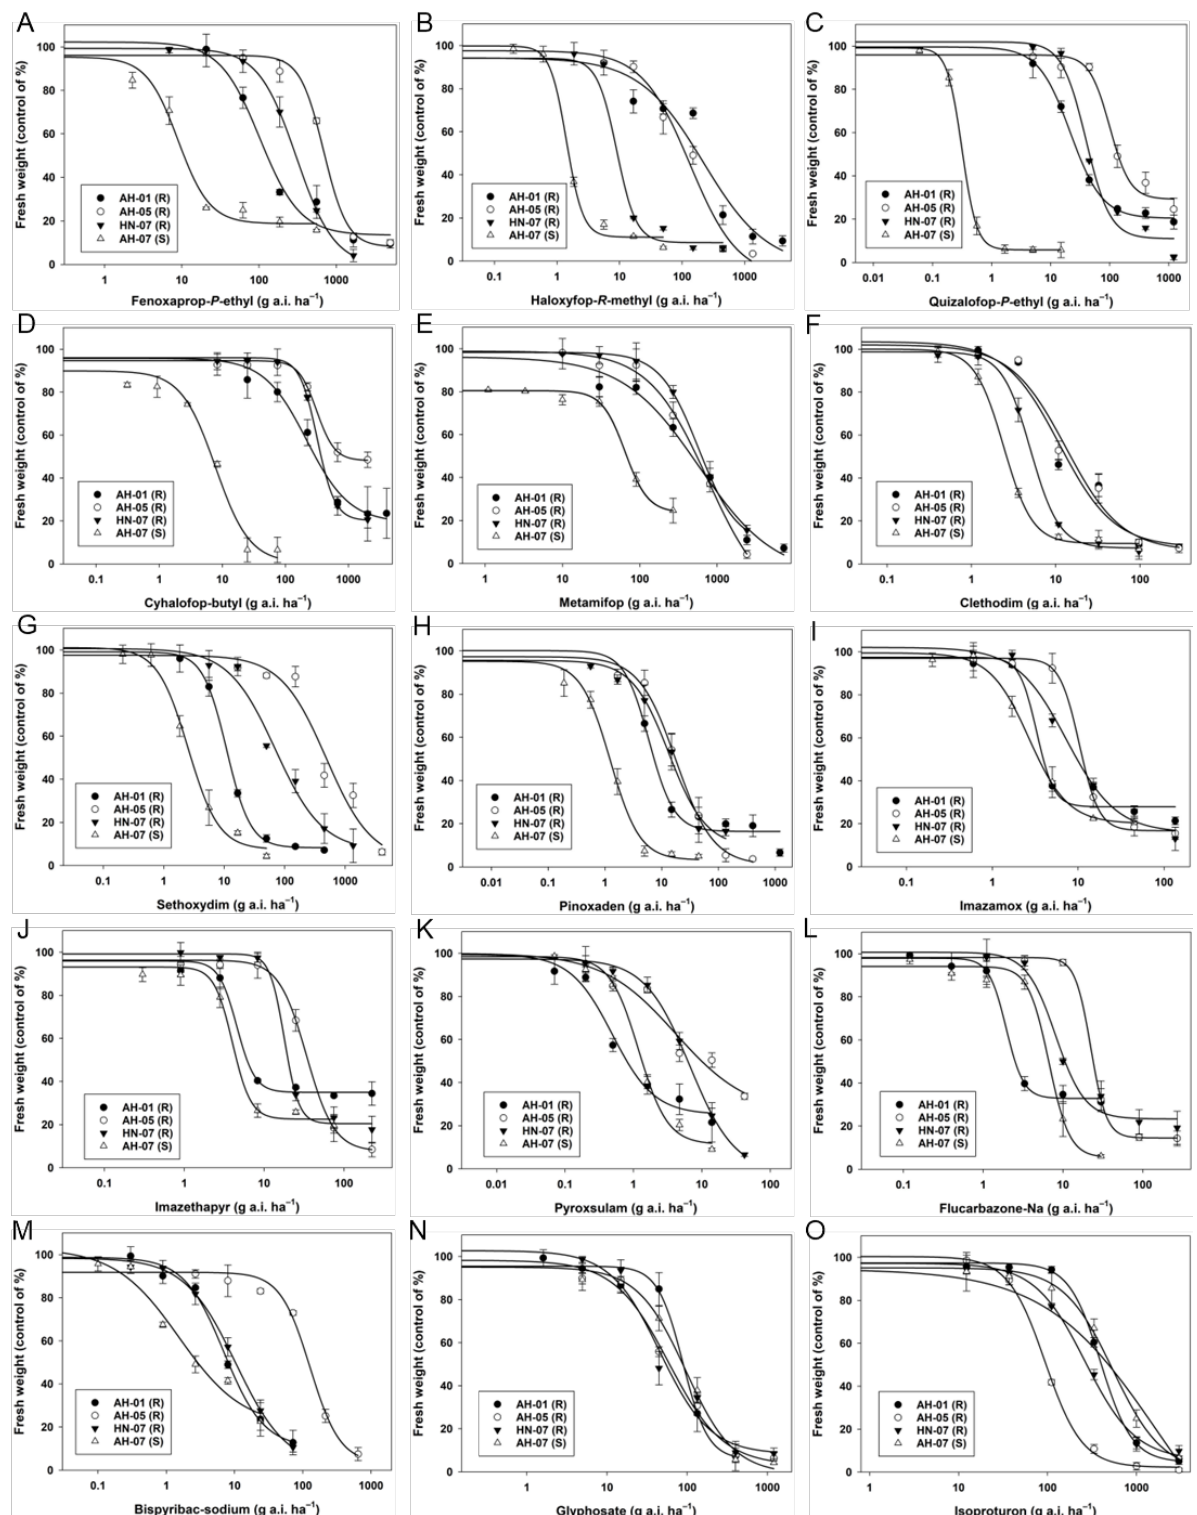
Figure 4. The doses-response curves of the aboveground fresh weights of the susceptible (AH-07) and different resistant (AH-01, AH-05, and HN-07) populations of L. multiflorum to ( A ) fenoxaprop- P -ethyl, ( B ) haloxyfop- R -methyl, ( C ) quizalofop- P -ethyl, ( D ) cyhalofop-butyl, ( E ) metamifop, ( F ) clethodim, ( G ) sethoxydim, ( H ) pinoxaden, ( I ) imazamox, ( J ) imazethapyr, ( K ) pyroxsulam, ( L ) flucarbazone-Na, ( M ) bispyribac-sodium, ( N ) glyphosate, and ( O ) isoproturon. Vertical bars represent the SE of the